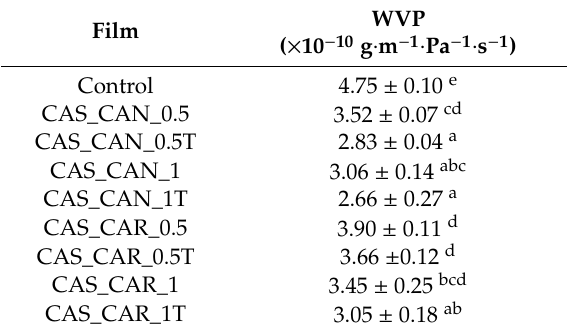
Table 5. Water vapour permeability (WVP) of sodium caseinate films with candelilla and carnauba